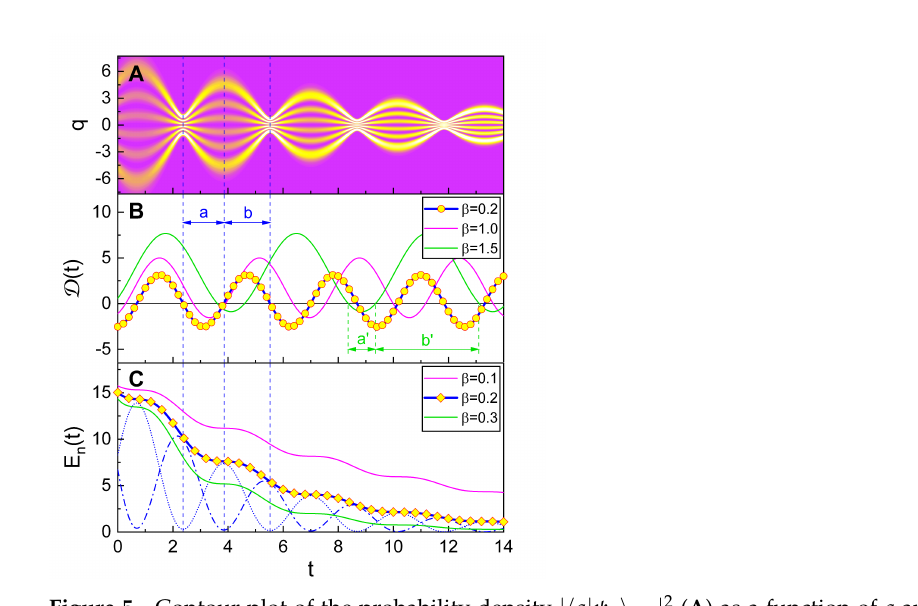
Figure 5. Contour plot of the probability density |(cid:104) q | ψ n (cid:105) GD | 2 ( A ) as a function of q and t for the quantum wave given in Equation (15), where we have chosen β = 0.2; the corresponding temporal evolutions of the ratio D ( t ) ( B ) and the quantum energy E n ( t ) ( C ) for several different values of β . a and b ( a (cid:48) and b (cid:48) ) in ( B ) are examples of time intervals of wave expansion and collapse, respectively, for β = 0.2 ( β = 1.5). The extra curves in ( C ), i.e., the dash-dot curve and the dotted curve are quantum electric energy T n ( t ) and the magnetic energy V n ( t ) , respectively, for the case of β = 0.2. We have used A = B = 3, n = 5, ω 0 = 1, ¯ h = 1, (cid:101) = 1, t 0 = 0, and ϕ = 0. This figure shows novel features of the general nonstatic waves, i.e., periodical behavior of wave collapse and expansion combined with the gradual dissipation.